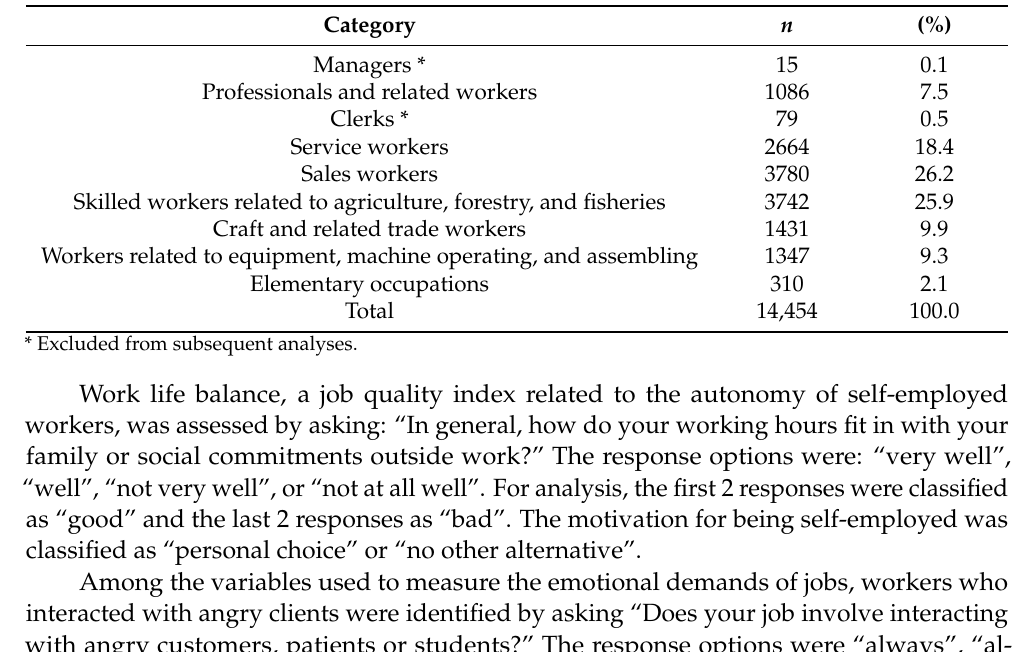
Table 1. Job categories of self-employed study